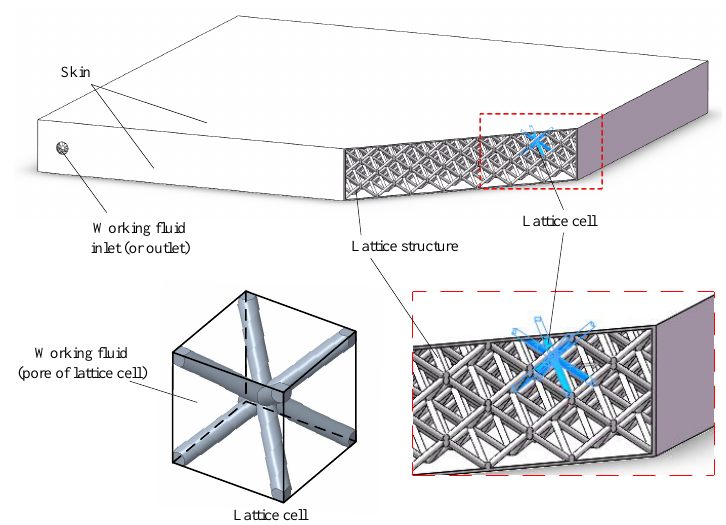
Figure 2. A typical heat exchanger with lattice